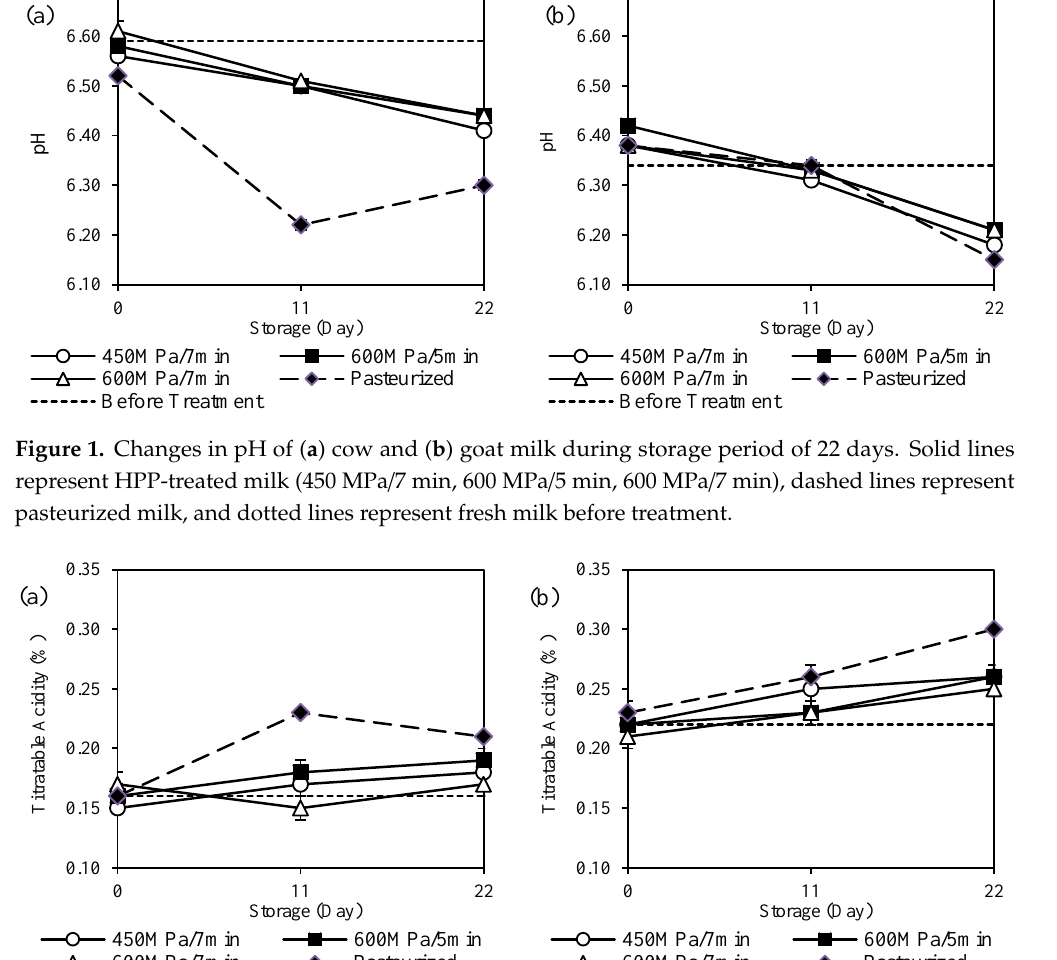
Figure 1. Changes in pH of ( a ) cow and ( b ) goat milk during storage period of 22 days. Solid lines represent HPP-treated milk (450 MPa/7 min, 600 MPa/5 min, 600 MPa/7 min), dashed lines represent pasteurized milk, and dotted lines represent fresh milk before treatment.